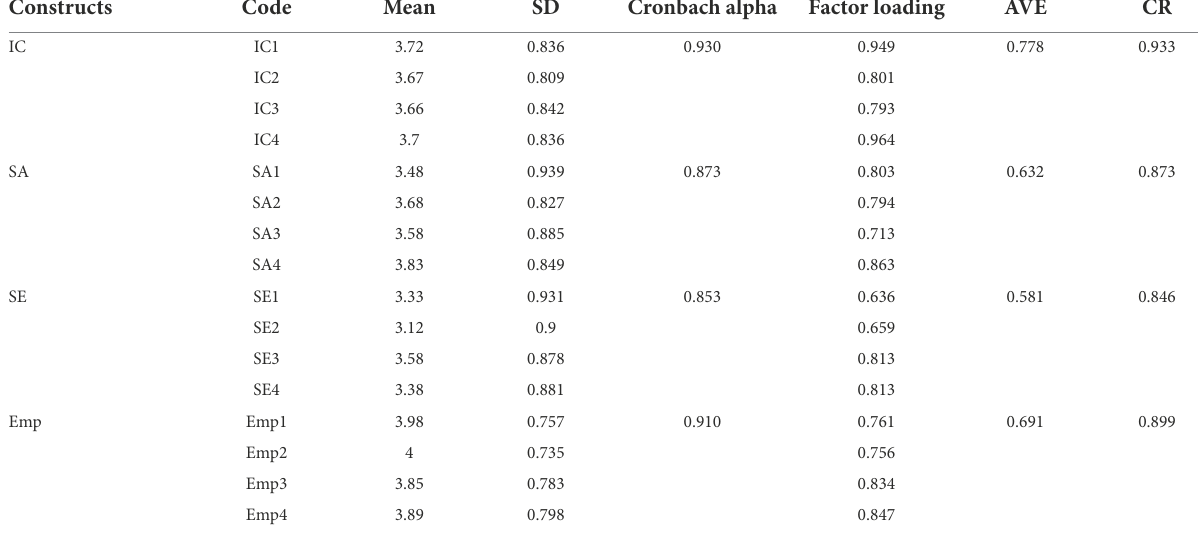
TABLE 2 Reliability and validity measures of the scale. Constructs